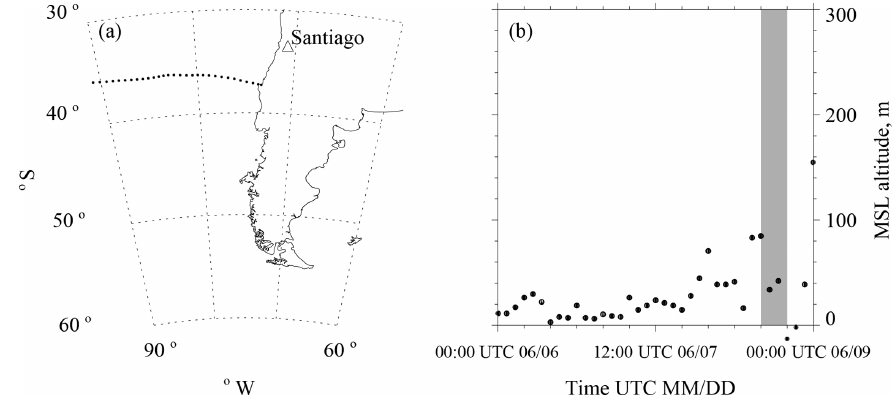
Figure 3. (a) One of the 18 sea surface trajectories that arrived at the Arauco site between 29 May to 28 June; this trajectory arrival occurred at 00:00UTC 9 June. Black dots are hourly output of the HYSPLIT model; however, for clarity, only every other 1h point is plotted. (b) Hourly parcel mean sea level (MSL) altitude vs. time; however, for clarity, only every other 1h point is plotted. The averaged sea surface wind speed ( U ) was evaluated over the 12:00 to 18:00UTC interval shown in gray. The MSL altitude was calculated using the pressure output by HYSPLIT (parcel barometric pressure) and the ICAO equation for the Standard Atmosphere (ICAO, 1993). The MSL altitude increases if a larger sea-level is pressure applied in the ICAO equation. This sensitivity is ∼ 8mhPa − 1